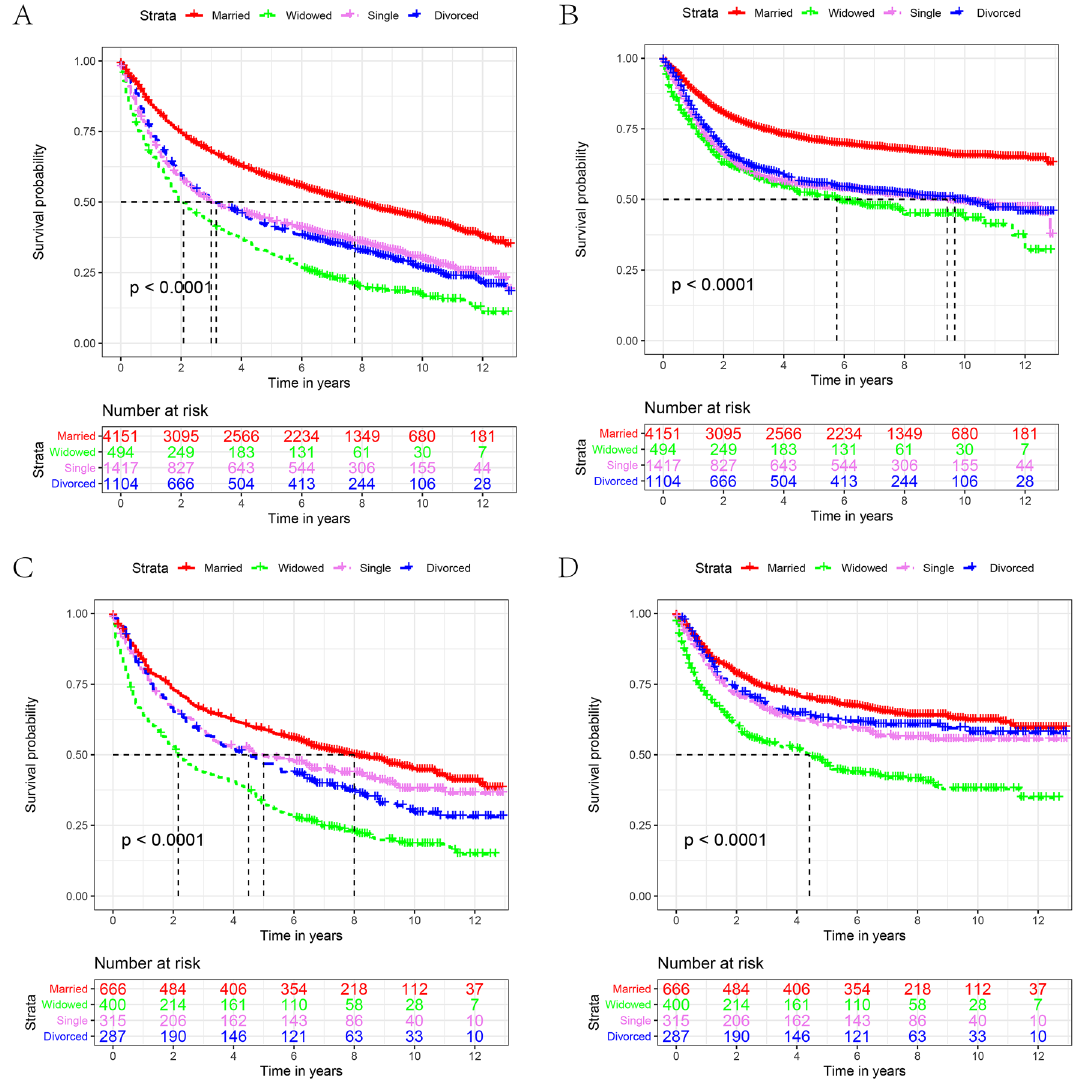
Figure 4. The OS and CSS curves of laryngeal cancer patients with different sex. A and B , OS and CSS for male. C and D , OS and CSS for female (OS: overall survival, CSS: cause-specific